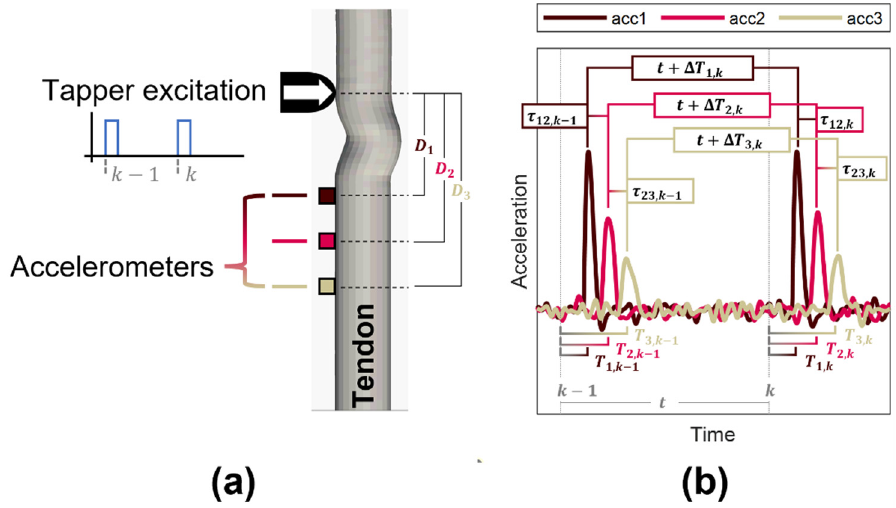
Figure 1. ( a ) A shear wave tensiometer fundamentally consists of an impulsive excitation which induces a shear wave in a tendon or other tissue. The wave travels longitudinally along the tissue. The wave is detected by an array of accelerometers that are adhered to the skin over a tendon. ( b ) An example of the wave measured at three accelerometers. Relevant times are defined for each accelerometer and pair: the variable T is the arrival time of the wave at each accelerometer, τ denotes the wave travel time between consecutive accelerometers, and ∆ T indicates the change in wave arrival time between consecutive excitations at a single accelerometer.